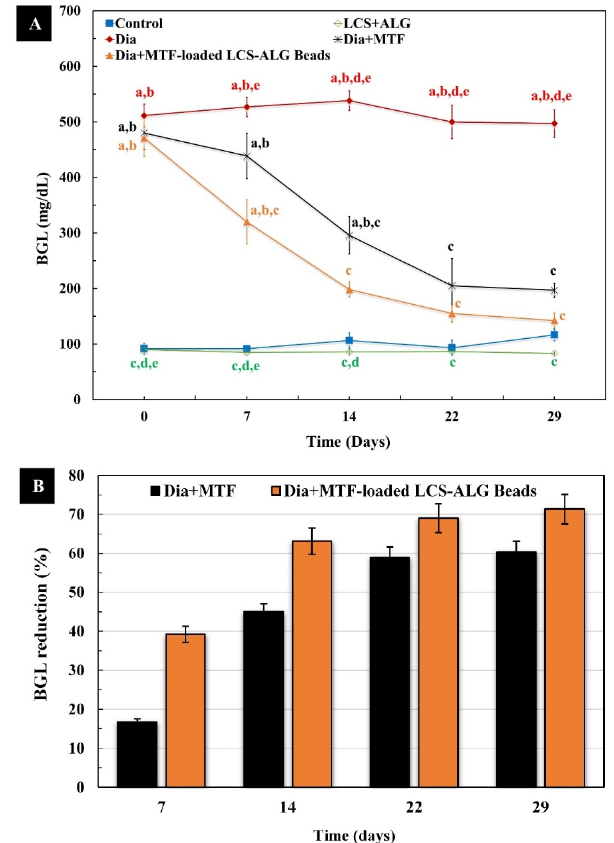
Figure 9. ( A ) Changes in blood glucose level, BGL (mg/dL), during the treatment period in the different studied groups. Data are presented as (mean ± SE, n = 6), significance at p < 0.05, a: significantly different when compared to control, b: significantly different when compared to LCS + ALG, c: significantly different when compared to Dia, d: significantly different when com- pared to Dia + MTF, e: significantly different when compared to MTF-loaded LCS-ALG bead group. ( B ) Percentage of reduction in BGLs of Dia + MTF and Dia + MTF-loaded LCS-ALG beads over 29 days. Solid lines are guides for the